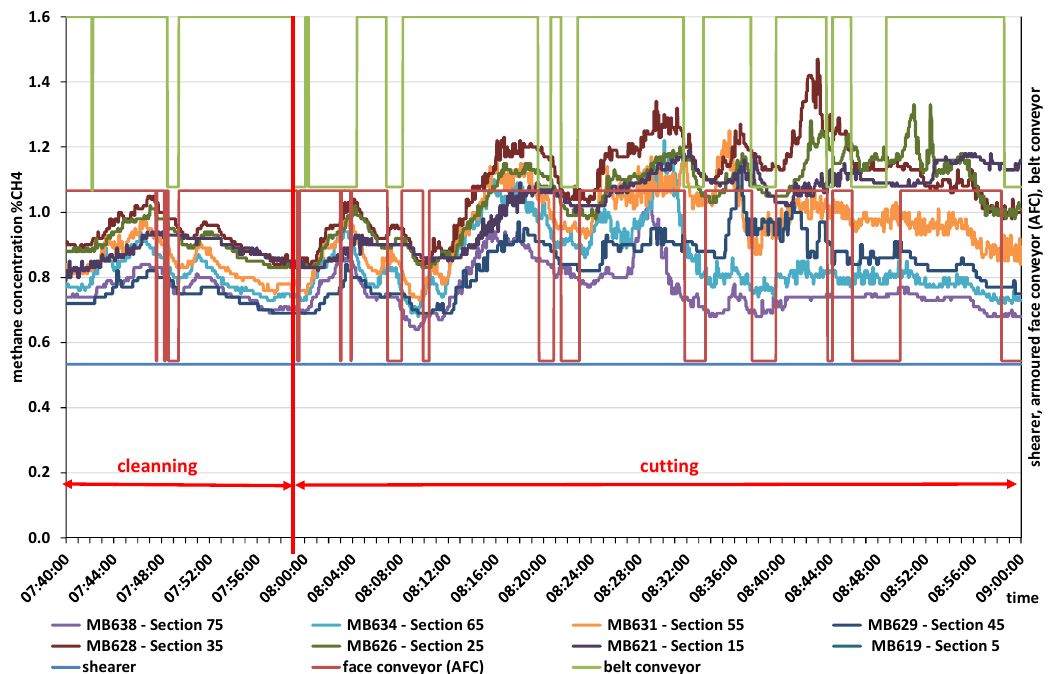
Figure 5. Recording of the methane concentration in the longwall Cw-4 area by means of wireless methane sensors (MB638-MB619), on 14 January 2014 between 7:40 and 9:00, in relation to equipment operation.